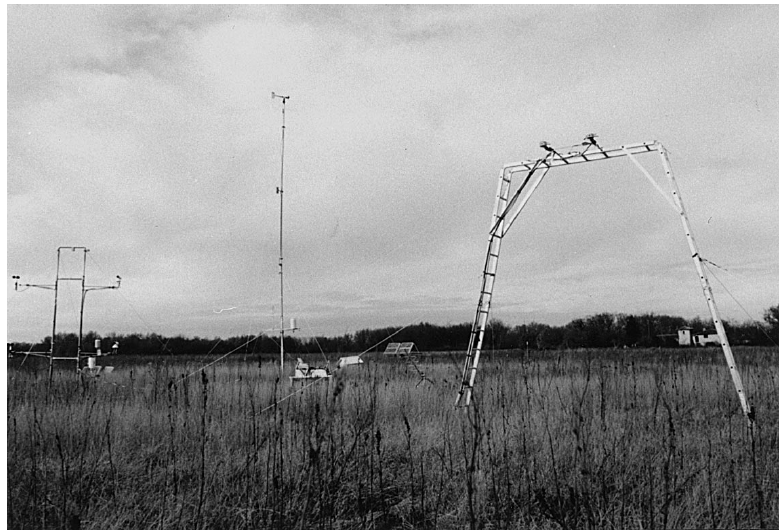
Fig. 1. Photograph of the central part of the MUREX fallow site (at the end of 1996) with some of the instrumentation. From left to right : the two-level SAMER system, the 10-m mast for wind, screen-level temperature and humidity, and IR-temperature, and the sca(cid:128)olding bearing the